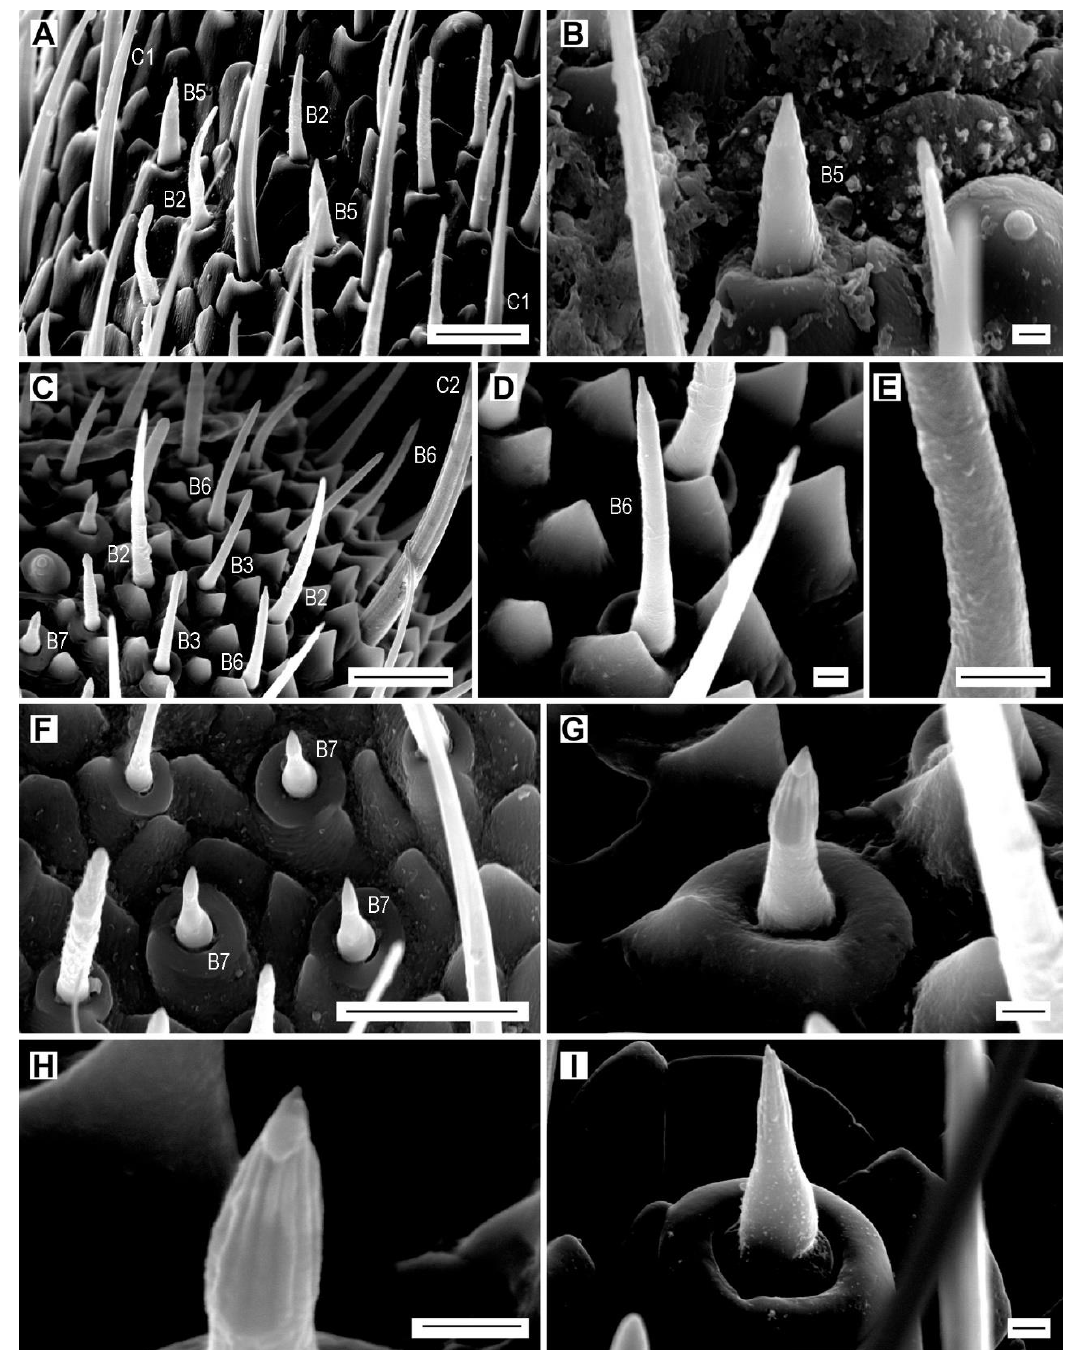
Figure 7. Sensilla basiconica of subtypes B5–B7. ( A ) A. modestus , female, sensilla chaetica C1 and basiconica B2 and B5 on antennomere XI; ( B ) A. pilosellus , male, sensillum basiconicum B5; ( C ) A. acuminatus , male, sensilla basiconica B2, B3, B6, and B7, and sensillum chaeticum C2; ( D ) A. acuminatus , male, sensillum basiconicum B6; ( E ) detail of the wall of sensillum B6; ( F ) A. rufipalpis , female, sensilla basiconica B7; ( G ) A. acuminatus , male, sensillum basiconicum B7; ( H ) detail of sensillum B7 showing the striae; ( I ) A. obscurus , female, sensillum basiconicum B7. Scale bars = ( A , C , F ): 10 μm; ( B , D , E , G–I ): 1 μm.